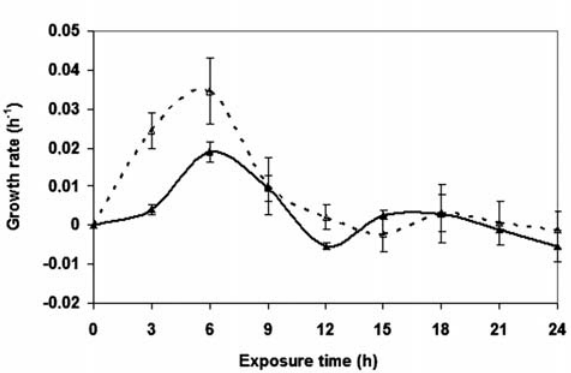
Fig . 3. – Cell instantaneous growth rate (µ=h -1 ) of Thalassiosira sp . as a function of the exposure time (hours) for surface and mix- ing treatments. Sfixed surface (filled triangles) and vertical mixing (open triangles). Vertical bars are standard deviations.